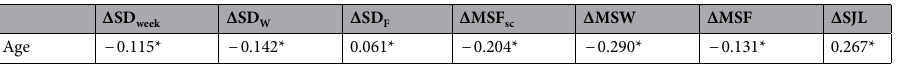
Table 1. Spearman’s correlations between responders’ age and deltas in daily behavior parameters. Values— Spearman’s ρ. *p <